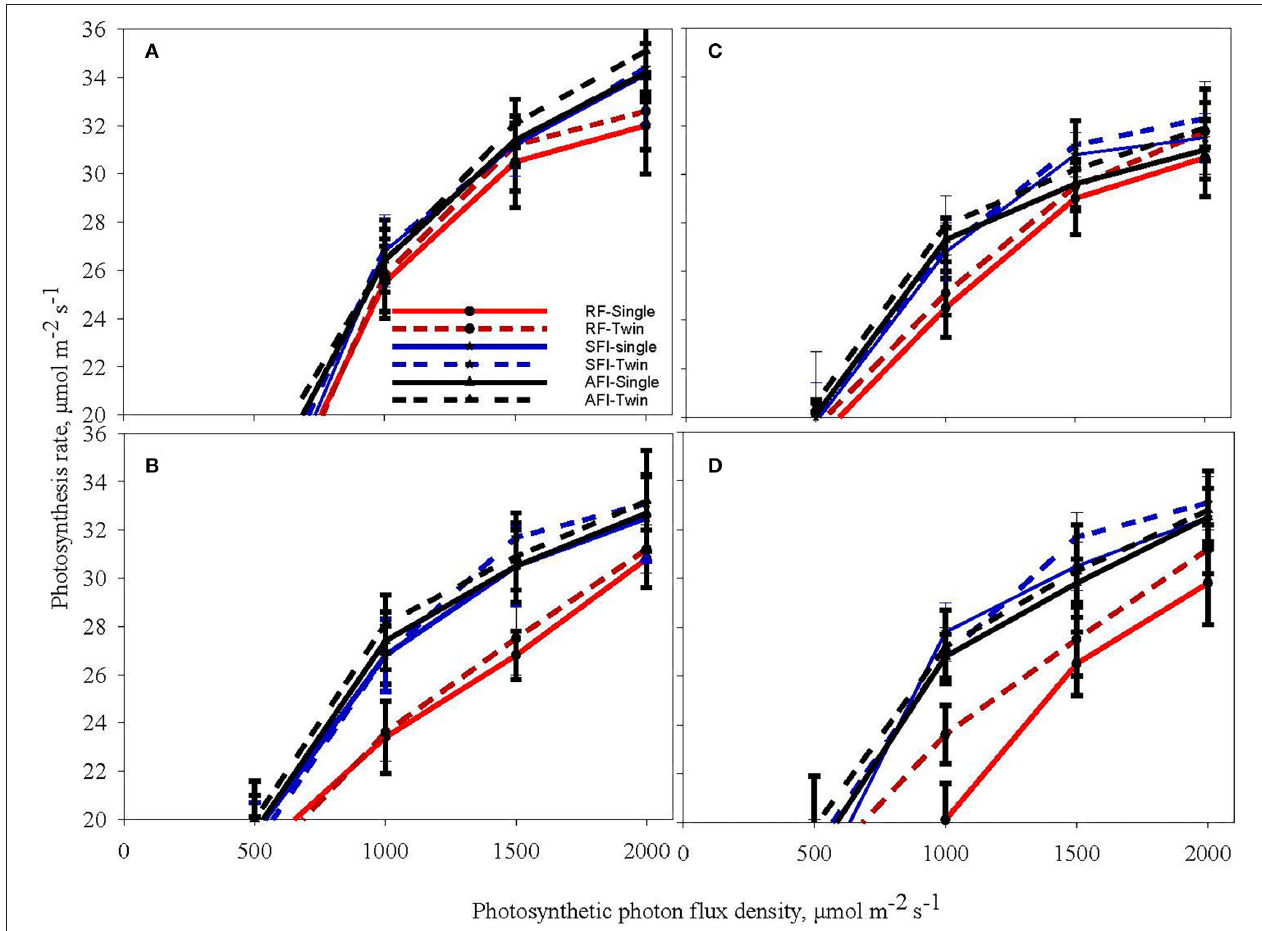
FIGURE 3 | Light response curves of cotton at the sixth leaf (V6) stage (A,B) and boll cracking stage-C5 (C,D) during the crop growing seasons in 2018 (A,C) and 2019 (B,D) at different levels of irrigation (AFI- all furrow irrigation SFI- skipped furrow irrigation and RF-rainfed) and planting geometries (SR-single row and TR-twin